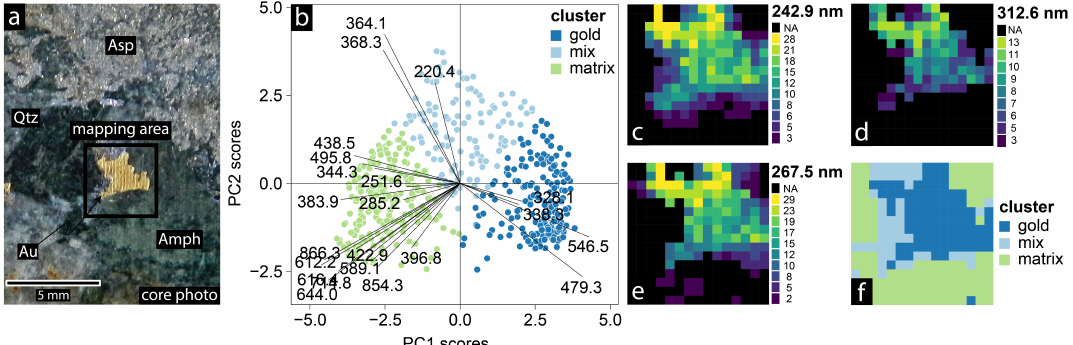
Figure 27. ( a ) Photo of coarse visible gold intergrown with quartz (Qtz) and amphibole (Amph) within an arsenopyrite (Asp)-rich quartz vein; ( b ) principal component analysis (PCA) biplot showing LIBS results and resultant wavelength loadings for one 16 × 16 grid map from 256 laser shots. Wavelengths are reported in nm units. Clusters of PCA scores are based on the k-means algorithm implemented in R [111]; ( c – e ) LIBS mapping results for the Au spectral lines at 242.9, 267.5, and 312.6 nm processed using new R code displayed as relative wavelength intensities (%); ( f ) LIBS map color coded to k-means clustering of PCA scores (same as b ). These maps highlight how chemometrics can be used to re-classify qualitative LIBS results to assist with mineral